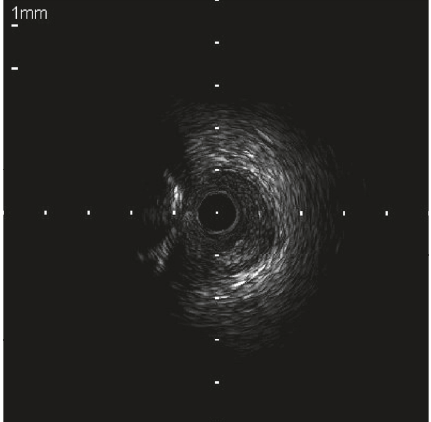
Figure 2: The calcified plaque blocks the entry of chronic total occlusion.